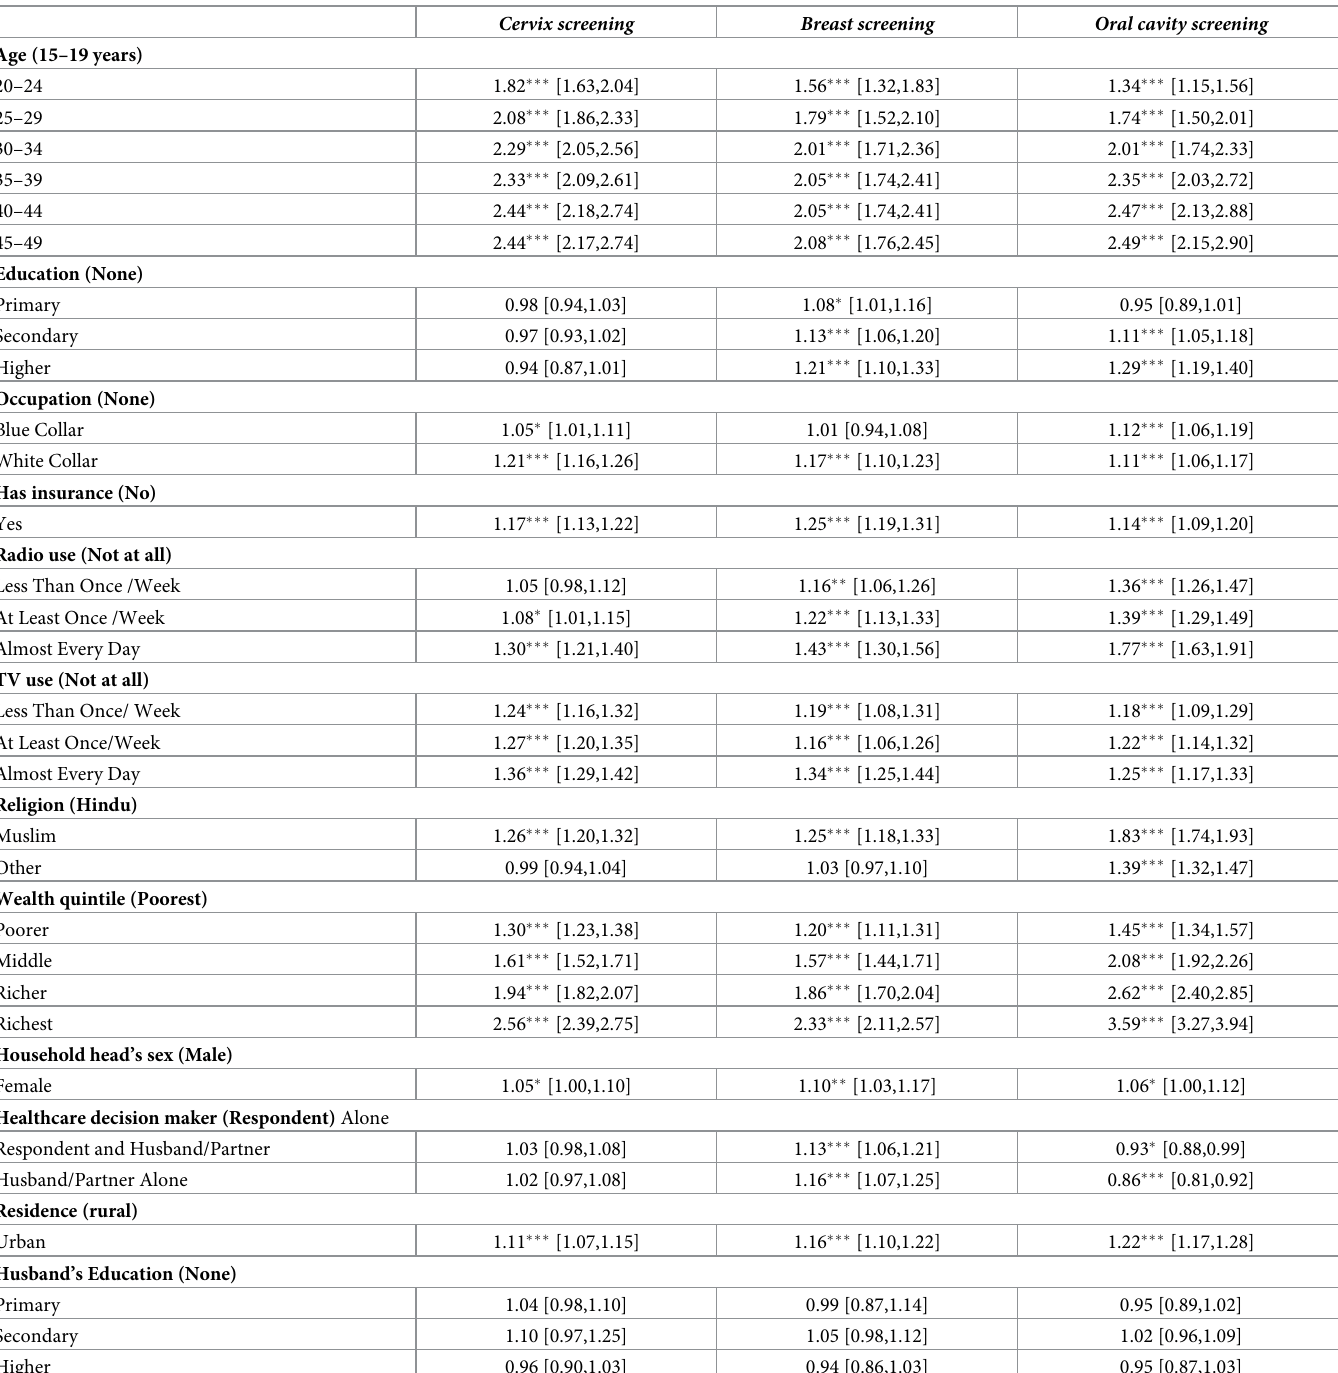
Table 3. Factors associated with cervix, breast and oral cavity screening among Indian